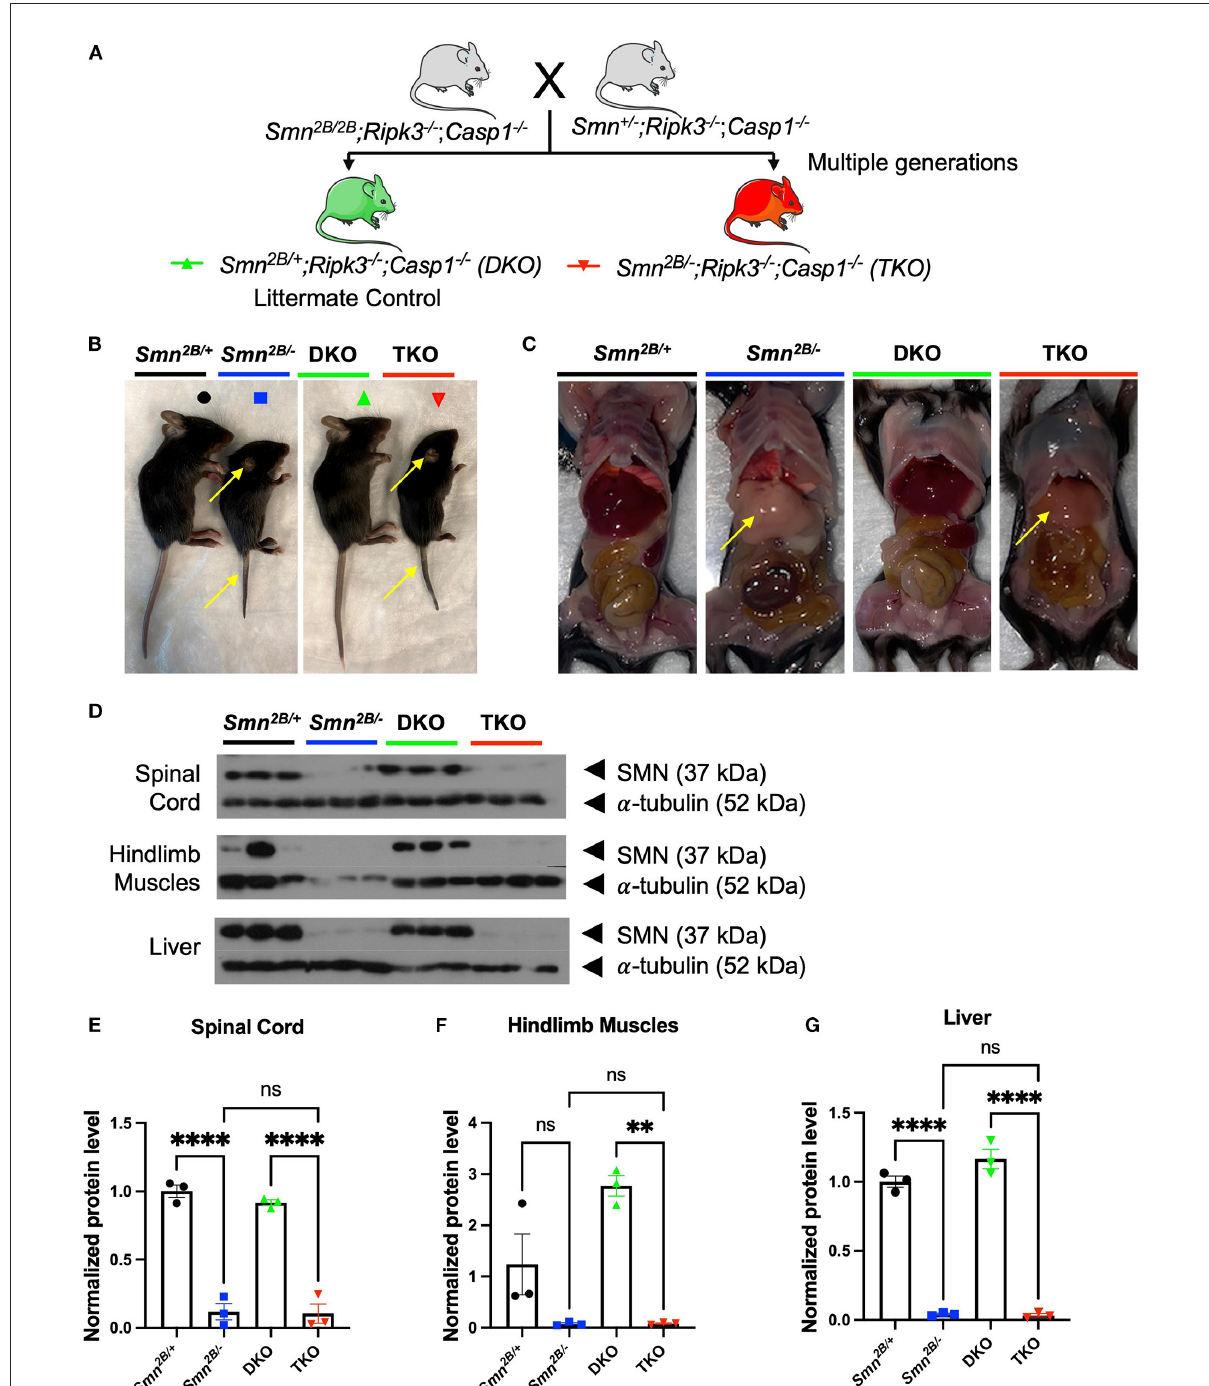
FIGURE1 Generation of necroptotic cell death pathway knockout mice on the Smn 2 B / − SMA mouse model background. (A) Schematic representation of the breeding scheme to generate the necroptotic pathway knockout on Smn 2 B / + background ( Smn 2 B / + ; Ripk3 − / − ; Casp1 − / − ). These double knockout mice (DKO, Green) do not develop an SMA-like phenotype and serve as controls. Smn 2 B / − ; Ripk3 − / − ; Casp1 − / − triple mutant mice (TKO, Red) harbor a necroptotic pathway knockout on the Smn 2 B / − mouse background. Parental strains were generated by multiple generations of crossings. Mice were compared to the Smn 2 B / + (control) and Smn 2 B / − (mouse model of severe SMA). (B,C) Representative images of Smn 2 B / + (Black), Smn 2 B / − (Blue), DKO (Green) and TKO (Red) at postnatal day 19 (P19) and gross phenotypic changes as denoted by the yellow arrows pointing to tail, ear necrosis, and fatty liver. (D) SMN and α -tubulin immunoblots of Smn 2 B / + control, Smn 2 B / − , DKO, and TKO mice spinal cord, muscle, and liver extracts. (E–G) Densitometric analysis of SMN western blots normalized to α -tubulin levels. Data represents means ± SEM with η = 4 per genotype. An ordinary one-way ANOVA with Tukey post-hoc test for multiple comparison was performed with p < 0.001 for ** , p < 0.0001 for **** , and ns,